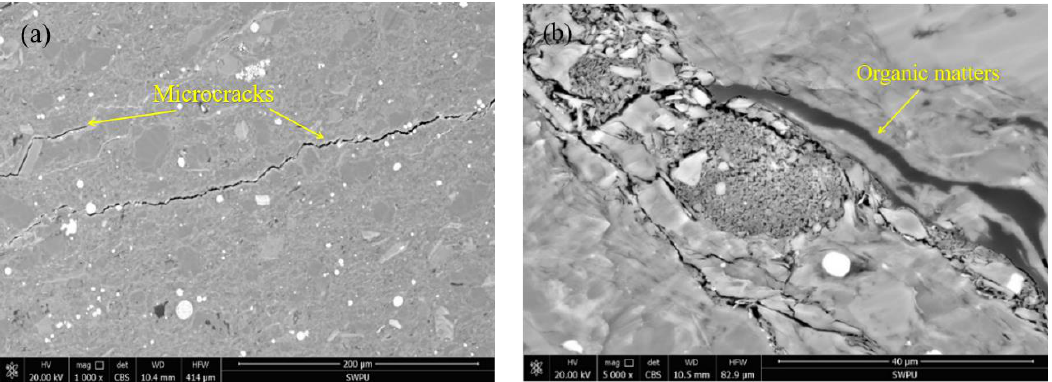
Figure 1. Microcracks ( a ), organic matter ( b ) and clay minerals observed by FESEM. N 2 adsorption is an important method to quantitatively characterize the nanoscale pores of shale. Obtaining N 2 adsorption-desorption curves through experiments can obtain the pore morphology, the ratio of macropores (>50 nm), mesopores (2–50 nm) and micropores (<2 nm) in nano-pores, and parameters such as specific surface area of shales [35]. The proportion of the pore diameter of each part in the shale determines the position of the imbibition fracturing fluid in the multiscale storage and seepage space of the shale, and the difficulty of the imbibition fracturing fluid flowback. If the shale pore size is smaller, the adsorption potential energy on the pore surface will be larger, which will affect the adsorption and desorption behavior of methane and water molecules in the shales. In this paper, seven shale samples are used for N 2 adsorption experiments. The results show that the specific surface area of shale samples ranges from 13.04 to 65.71 m 2 /g, and the average specific surface area is 34.02 m 2 /g. The total pore volume of the shale samples ranged from 0.03 to 0.13 cm 3 /g, with an average total pore volume of 0.05 cm 3 /g. The pore size of shale samples ranges from 4.2 to 7.7 nm, with an average pore size of 5.8 nm. The pore types of shale samples are mainly mesopores, which account for about 85% of the total pore volume of shale samples.